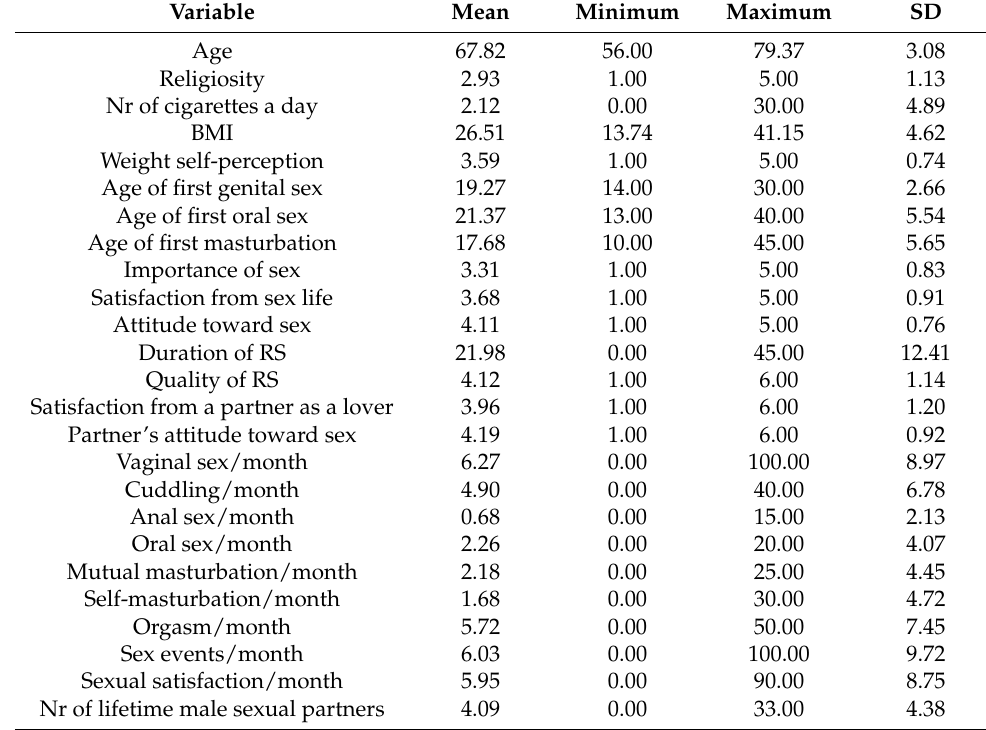
Table 2. General characteristic of the studied population—quantitative